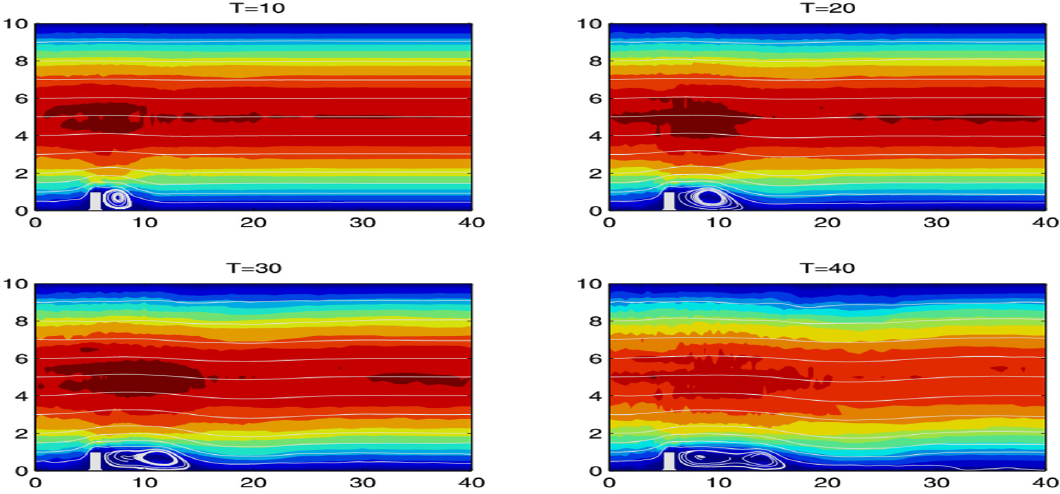
Figure 6. Four snapshots ( t = 10,20,30, and 40) of the nonlinear TRM with deconvolution order N = 1, filter length δ = 0.5, and relaxation term χ = 3.0. Shown are streamlines overlaid above speed contours | v ( x , t ) | . This figure was originally published in h